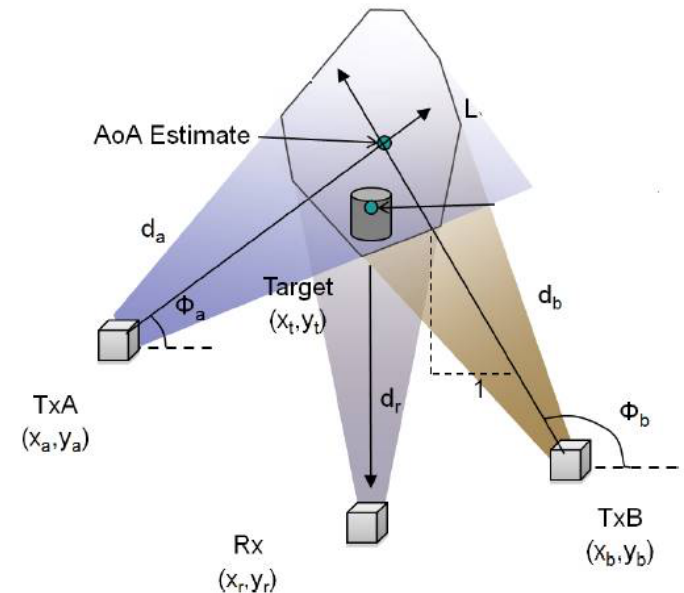
Figure 7. The idea behind the AoA-based technique: the AoA is calculated representing the direction in which the signal is